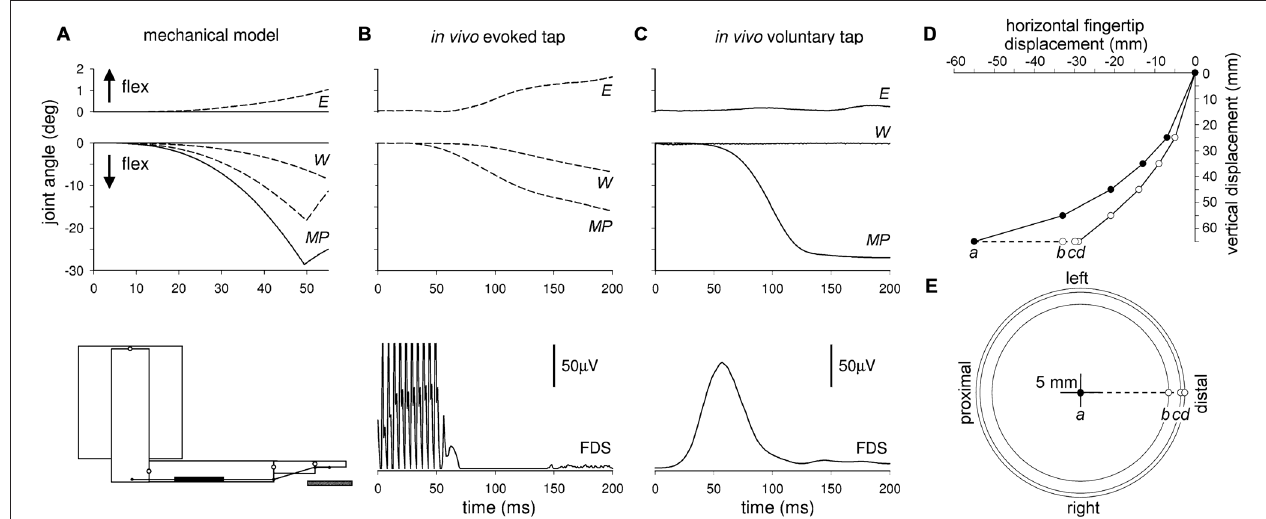
FIGURE 3 | Comparison of arm joint kinematics during a simulated, an in vivo evoked and a voluntary finger flexion. Time course of a finger flexion at the metacarpophalangeal ( MP ) joint, and the related changes at wrist ( W ) and elbow ( E ) level, measured in an arm mechanical model (bottom-left inset) when the proximal segments were free to rotate (A , dashed lines ) or when they were immobilized (A , solid lines ) , so as to produce fictive APAs. Angular displacements of the three joints were also recorded when an index-finger tap was passively evoked in vivo by electrical stimulation of the median nerve (B) and when it was voluntary performed (C) Rectified EMG activity of prime mover FDS in the two lower graphs. Note that the mechanical model well predicts the displacements of the proximal joints both during voluntary (solid lines) and evoked (dashed lines) index-finger tap. Panel (D) illustrates the simulated fingertip trajectory when the proximal segments were immobilized (filled circles, fictive APAs), and when they were free to rotate (empty circles). Note that for a vertical displacement of 65 mm, the fingertip hits the table surface (dashed line) more proximally with fictive APAs ( a ) then without them ( d ). Dots c and b mark the hitting position when the fictive APAs were restrained to the sole shoulder or to shoulder plus elbow, respectively. In the planar graph (E) the filled circle is the univocal target position theoretically resulting from a fully expressed APA control. Any disturbance of the APA chain would necessarily lead to impact any other point. Reproduced from Caronni and Cavallari (2009a), © ~ Springer-Verlag 2008, with permission of Springer